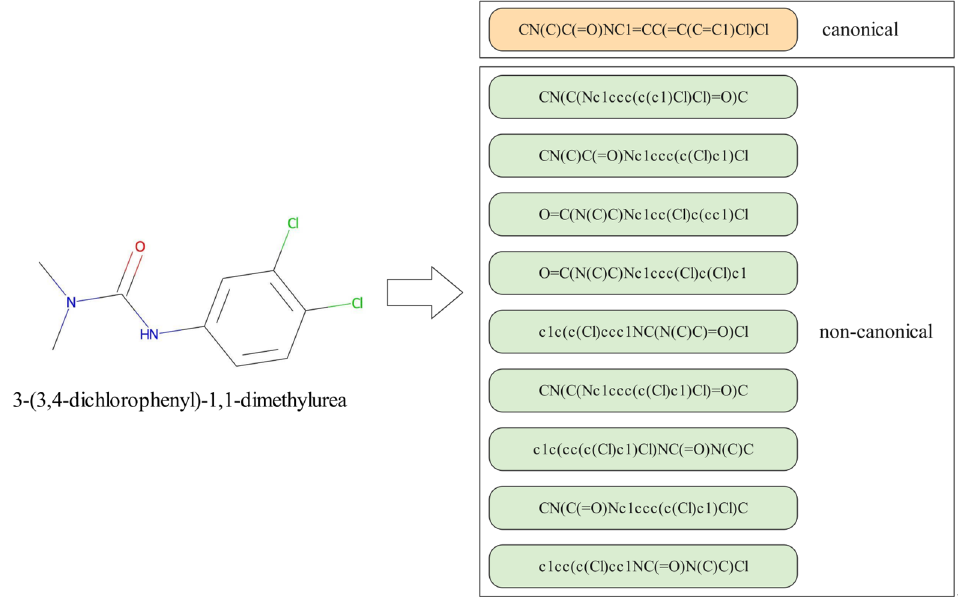
Figure 3. The canonical and non ‐ canonical SMILES representations of the molecule 3 ‐ (3,4 ‐ dichloro ‐ phenyl) ‐ 1,1 ‐